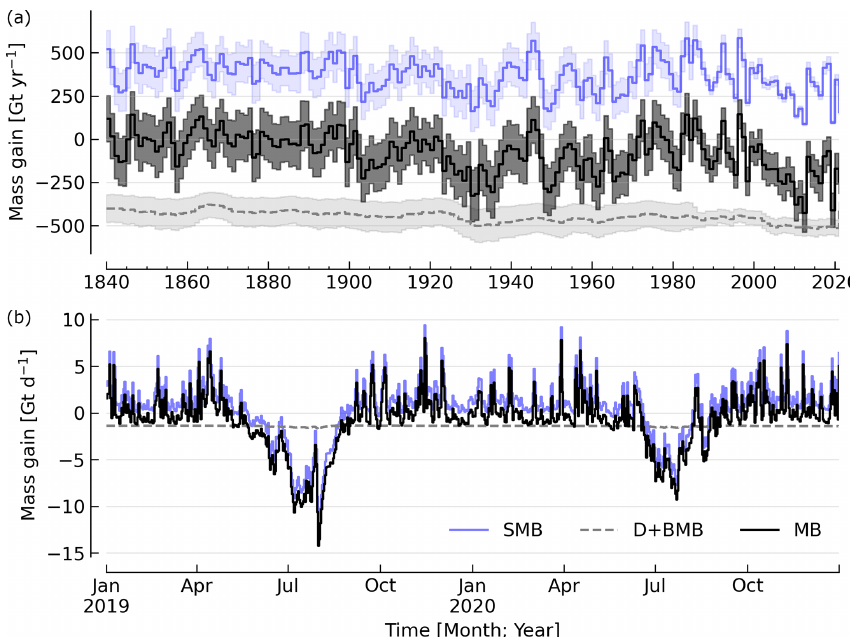
Figure 2. Mass balance and its major components. (a) Annual average surface mass balance (blue line), discharge (gray dashed), and their mass balance sum (black line). Here the discharge and basal mass balance (D + BMB) are shown with sign inverted (e.g., − 1 × (D + BMB)). (b) Same data at daily resolution and limited to 2019 and